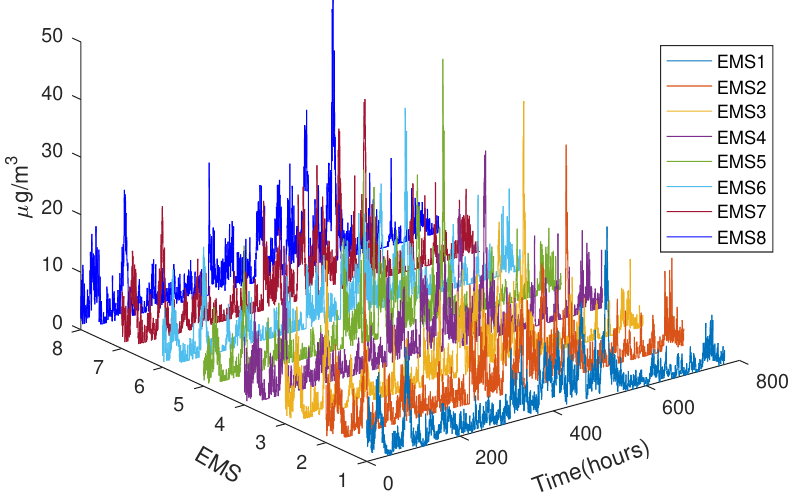
Figure 8. On-site PM10 concentration during 15 February–17 March